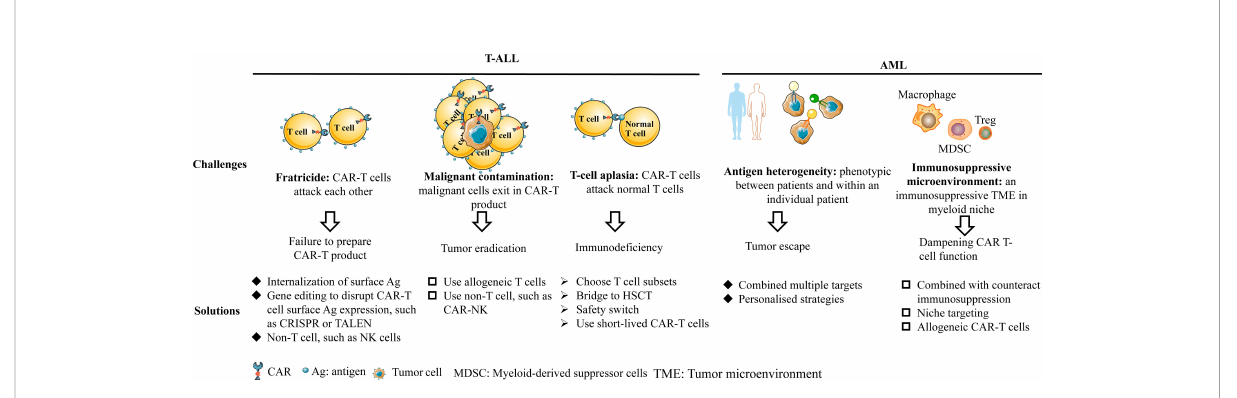
FIGURE 3 The challenges and solutions for T-ALL and